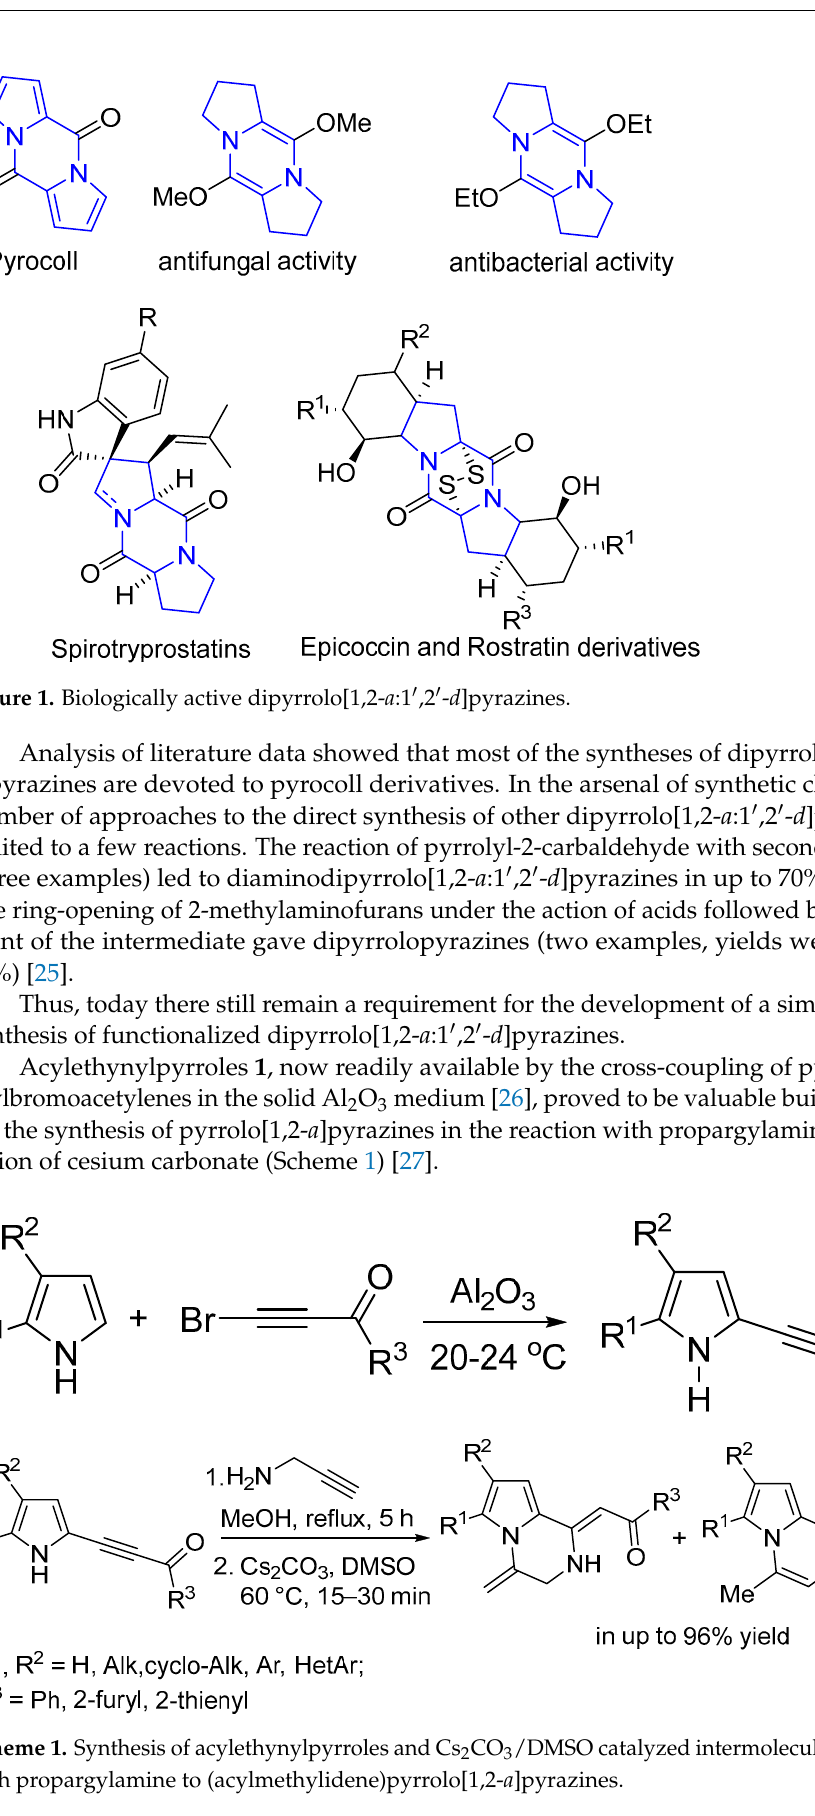
with propargylamine to (acylmethylidene)pyrrolo[1,2- a